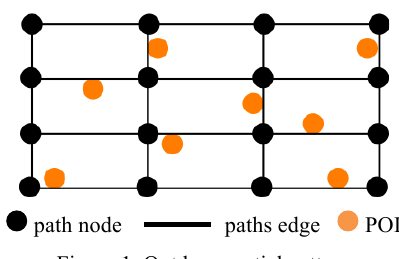
Figure 1. Outdoor spatial pattern